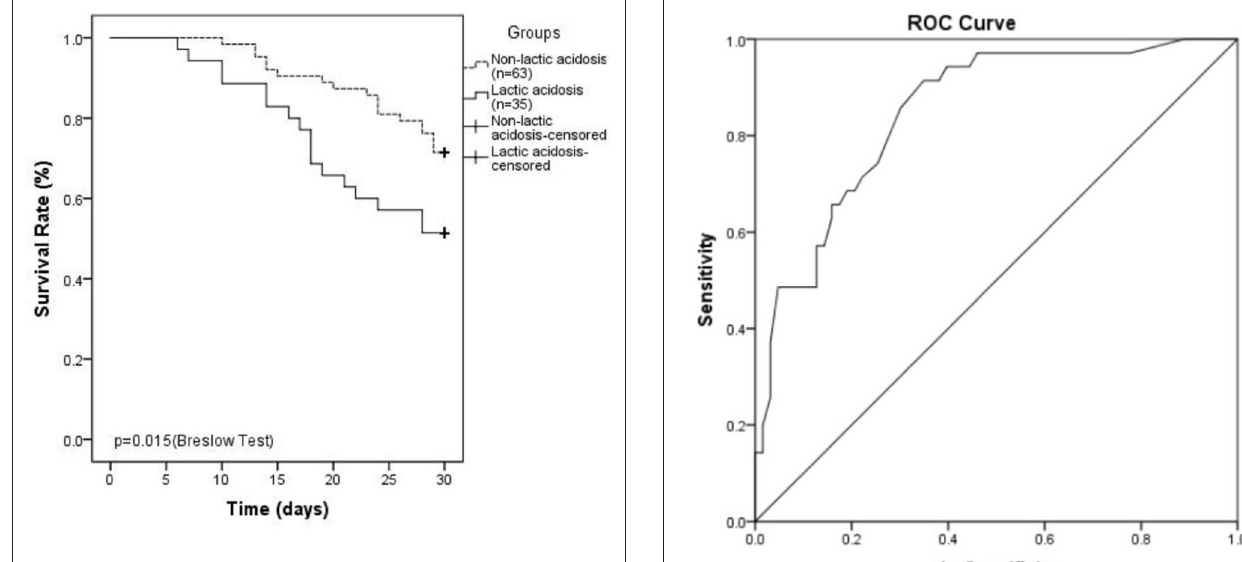
FIGURE 2 | Kaplan–Meier plot showing 30-day survival ratesinlinezolid-induced lactic acidosis group is lower than that in non-lactic acidosis group (48.6 vs. 28.6%, P = 0.015). TABLE 4 | Multivariate analyses of risk factors for linezolid-induced lactic acidosis.